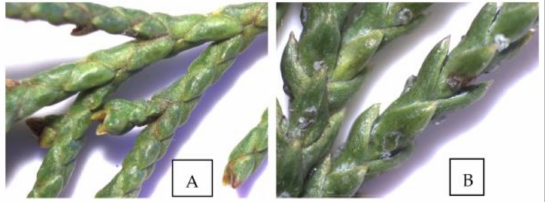
Figure 1. Images of the leaves of J. sabina ( A ) and J. excelsa ( B ) taken with a Stereo Microscope DM-143-FBGG, Motic Images Plus